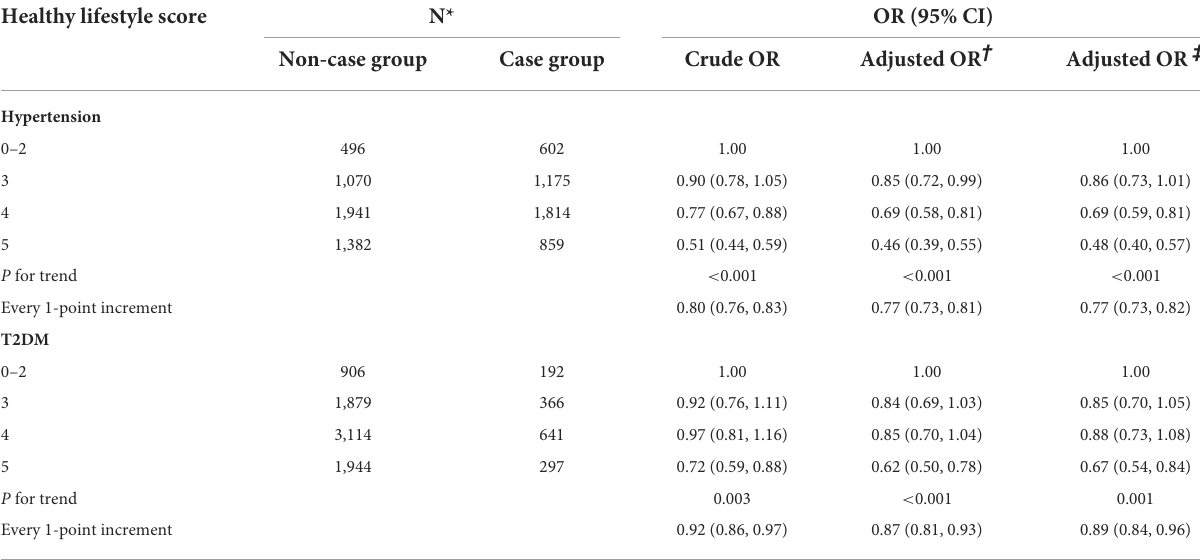
TABLE 3 Association between healthy lifestyle score and the risk of hypertension and